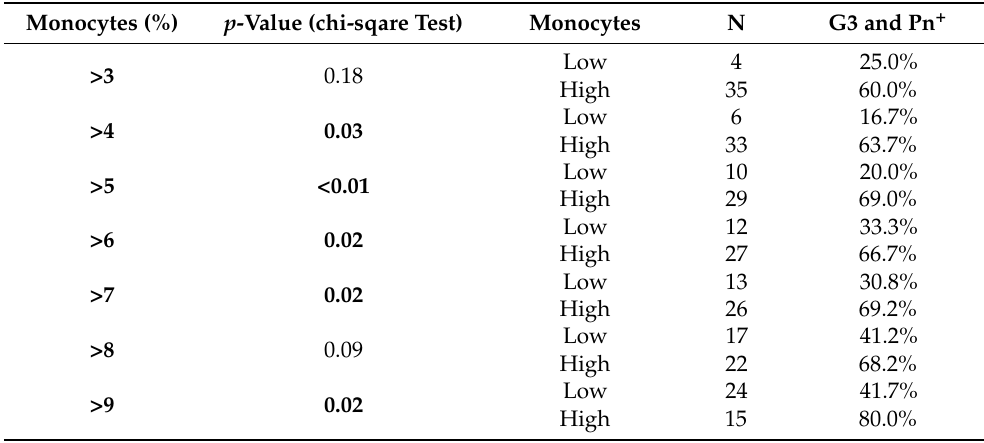
Table 2. Determining the cutoff threshold of the percentage of monocytes based on the aggressiveness of tumor growth (G3 and Pn + ) using the two-tailed minimal p -value approach (chi-square test; n = 39). The optimal cutoff value with the lowest p -value is marked grey. Statistically significant valus are highlighted in bold.